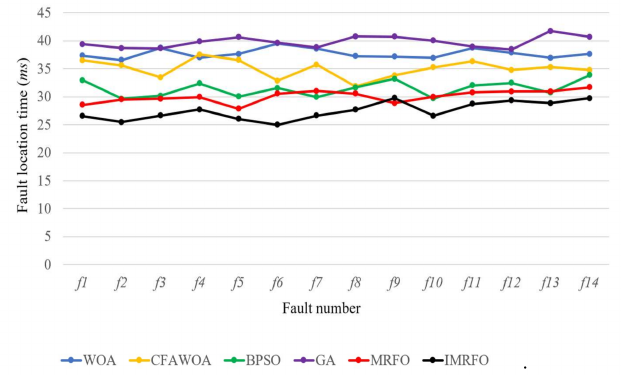
Figure 8. Comparison of fault location time consumption. The average time consumption of the IMRFO algorithm is the lowest, approximately 27.48 ms. The average time consumption of the MRFO algorithm before the improvement is 30.06 ms. After the improvement, the fault location rate is increased by 29.15%. In order to further verify the rate and fault tolerance of IMRFO in distribution network fault location, four different fault cases are selected from the above-mentioned fault conditions, respectively. Additionally, the convergence curve plots of various algorithms for fault location under different fault conditions are analyzed. The convergence curve plots are shown in Figure 9.